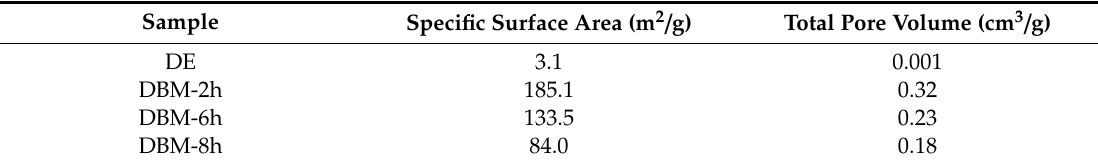
Table 2. Specific surface area and total pore volume of the DE and DBM.